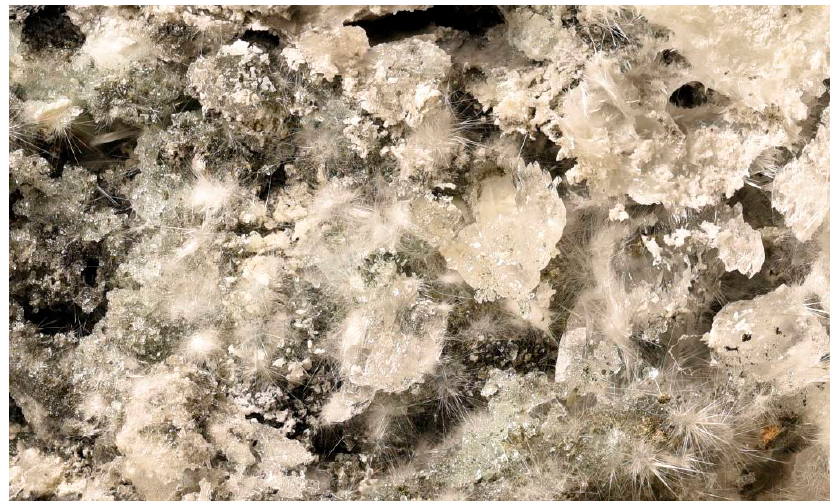
Figure 26. Wilcoxite, triclinic colorless crystals, up to 5 mm in length, associated with colorless granular